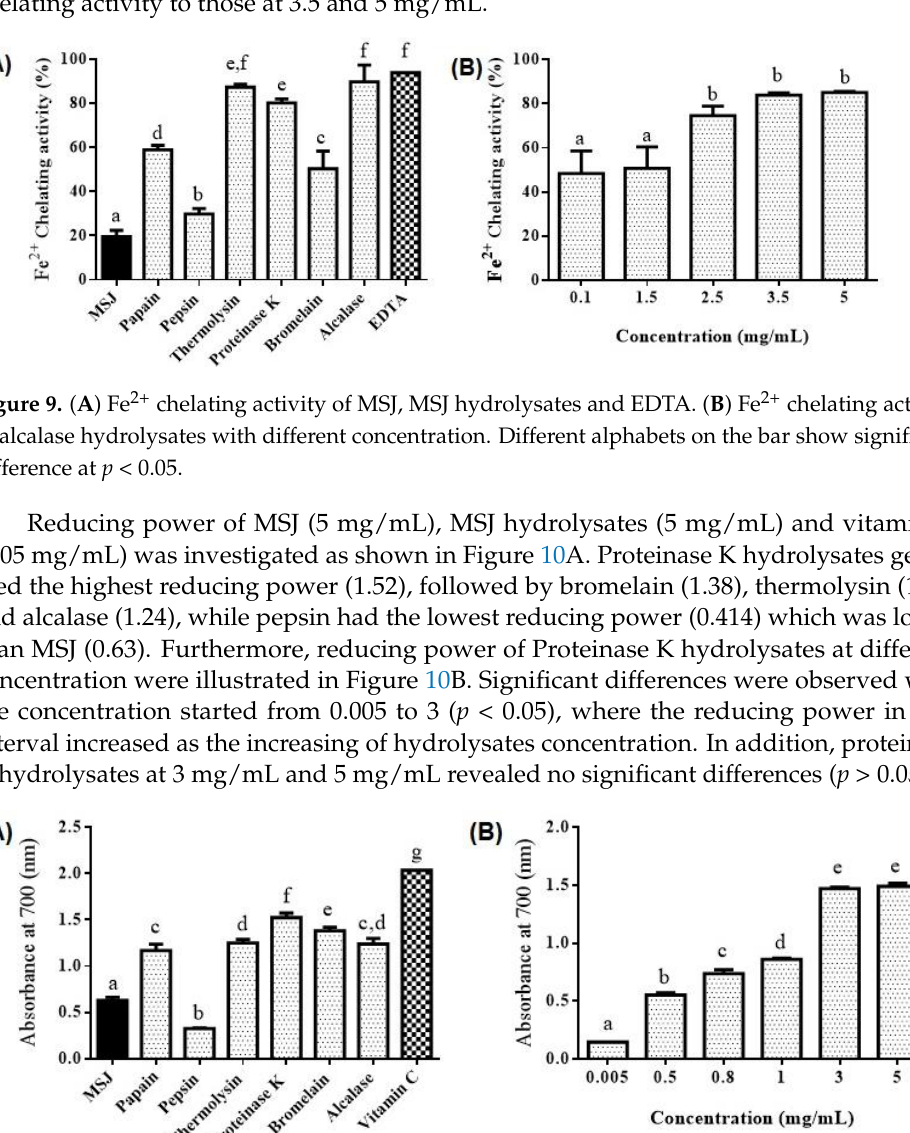
Figure 8. ( A ) DPPH radical scavenging activity of MSJ (5 mg/mL), MSJ hydrolysates (5 mg/mL) and Vitamin C (0.05 mg/mL). ( B ) DPPH radical scavenging activity of pepsin hydrolysates with different concentration. Different alphabets on the bar show significant difference at p < 0.05. NA indicates no activity found.